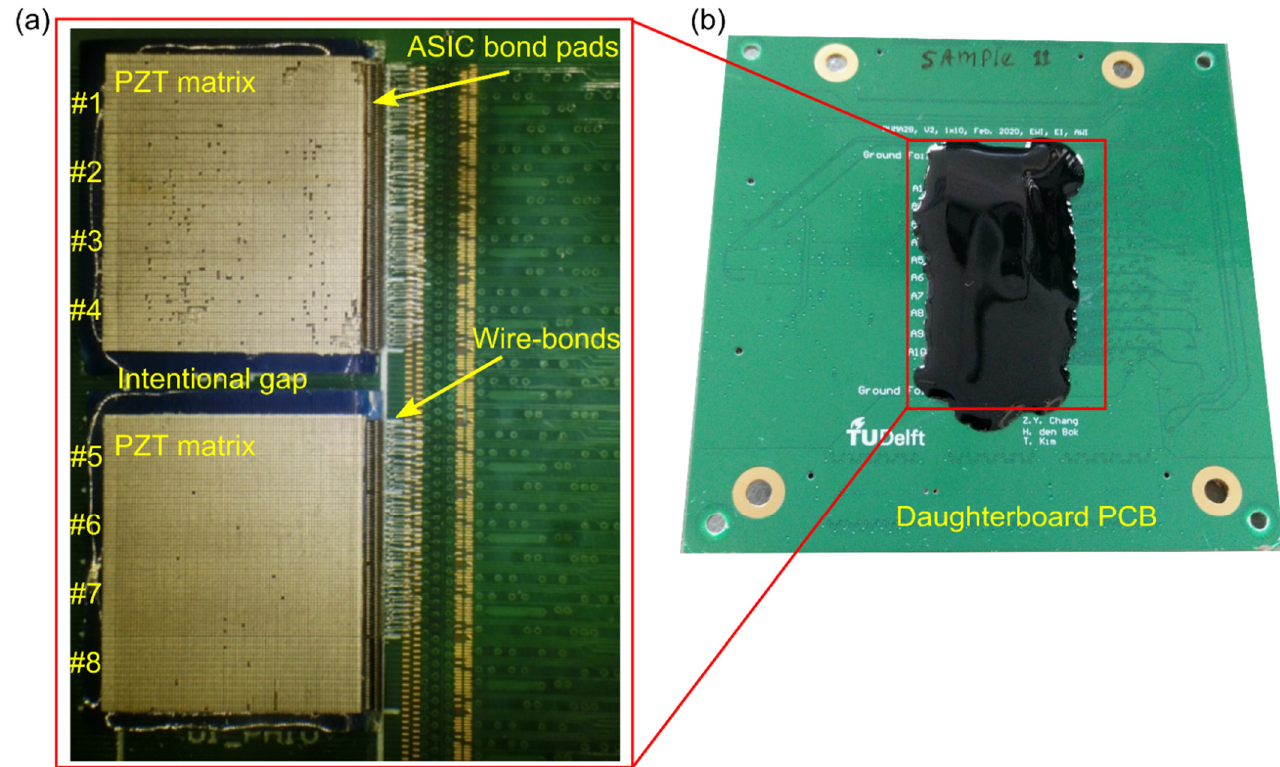
Figure 5. Photograph of the prototype transducer. ( a ) Fabrication of the PZT matrix with 96 × 80 (rows × columns) elements on top of 8×1 tiled ASICs. ( b ) The finished transducer on the daughter- 96 × 80 (rows × columns) elements on top of 8 × 1 tiled ASICs. ( b ) The finished transducer board. on the